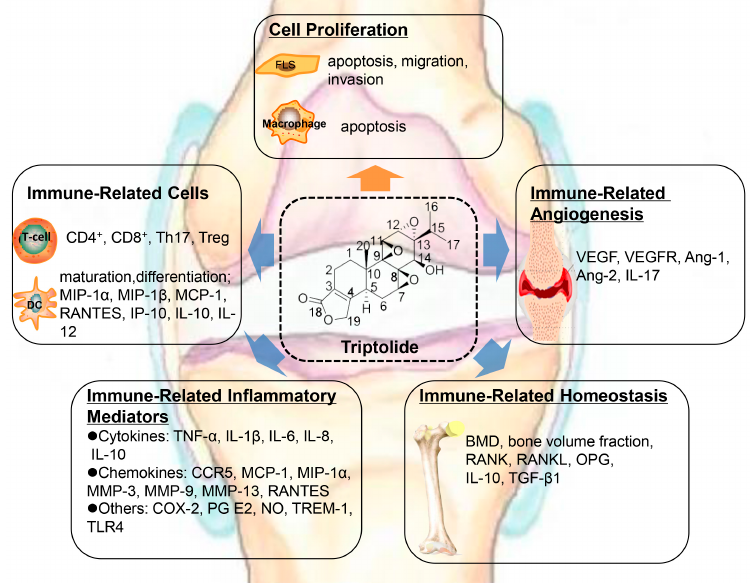
Figure 2. Schematic illustration of TP properties in the treatment of rheumatoid arthritis (RA).